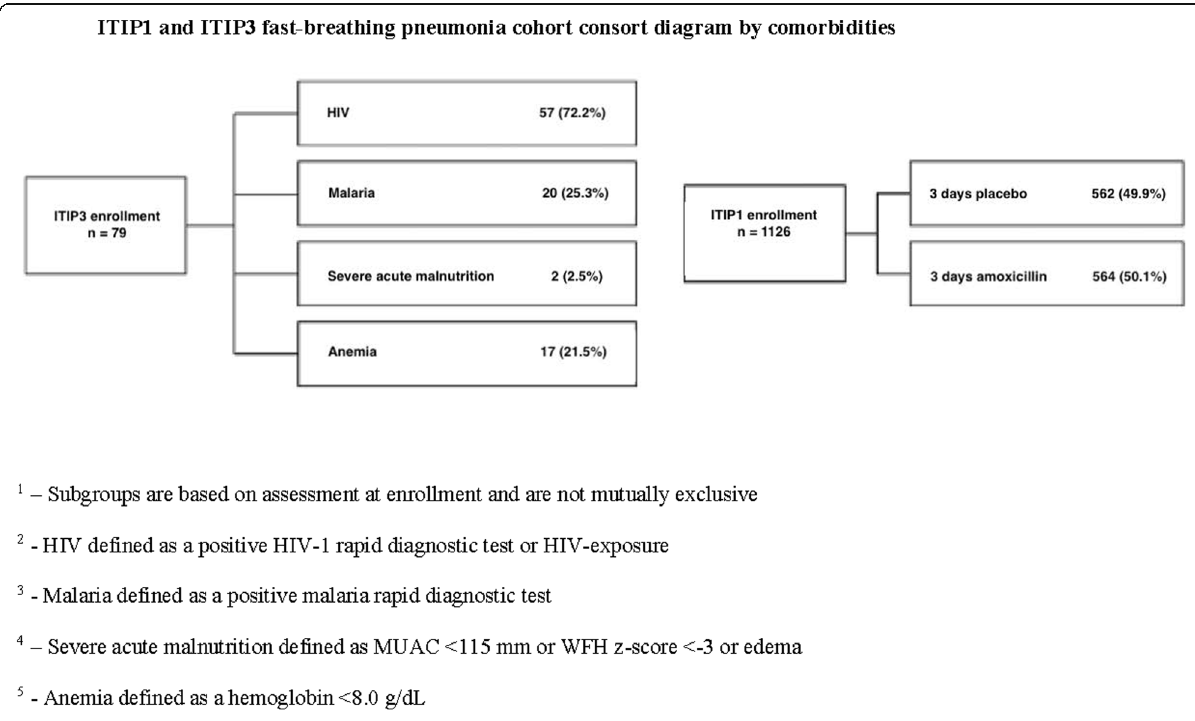
Fig. 1 ITIP1 and ITIP3 fast-breathing pneumonia cohort consort diagram by